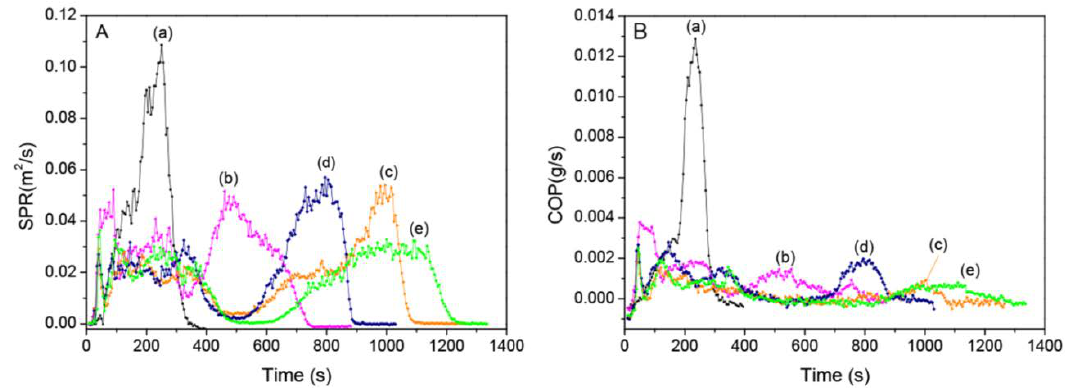
Figure 9. ( A ) Smoke production rate (SPR); and ( B ) production rate of CO (COP) curves of EVA and composites. ( a ) EVA; ( b ) ELDH - 0; ( c ) ELDH - Ni; ( d ) ELDH - Co; and ( e ) ELDH - Cu.